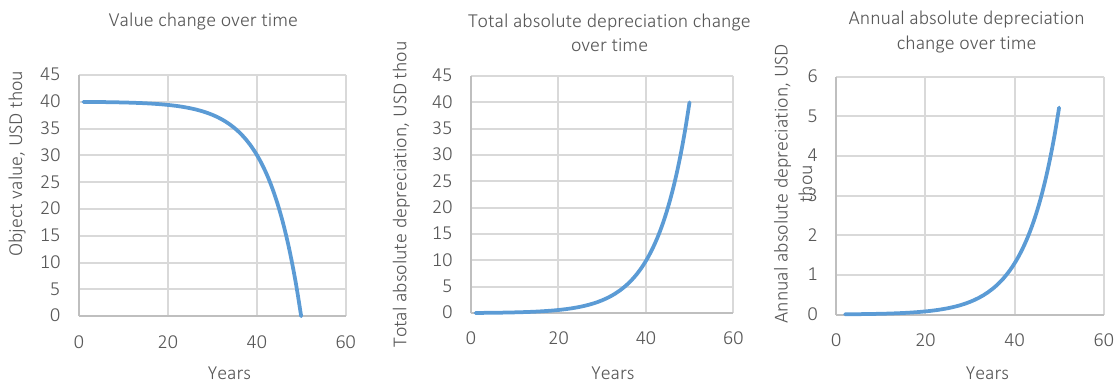
Figure 1. Graphs of the value change over time (left); total absolute accumulated (middle) and the annual (periodic) absolute depreciation (right). Traditional progressive depreciation model, based on